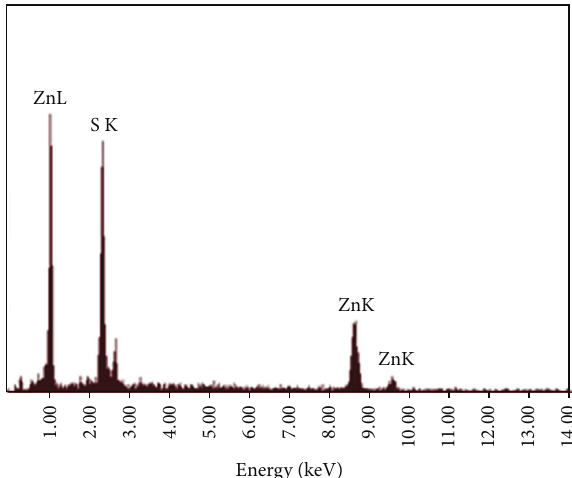
Figure 3: EDX spectrum of ZnS nanospheres.